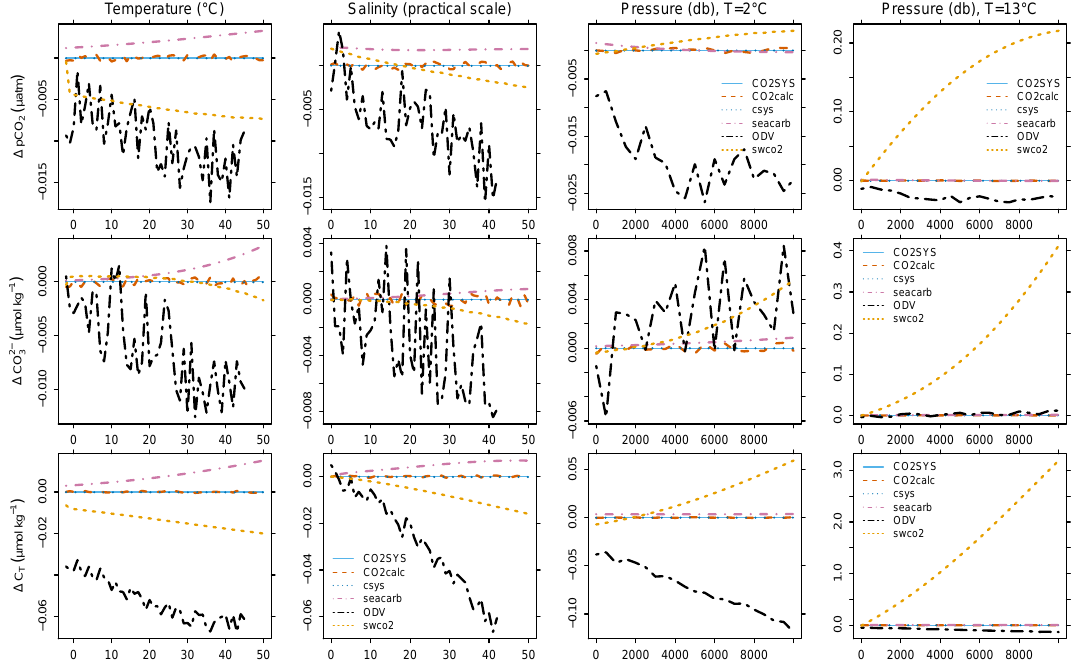
Figure 6. Variables computed from A T and pH with each package minus corresponding results from CO2SYS-MATLAB. Shown are com- puted p CO 2 (top), CO 2 − (middle), and C T (bottom) across ranges of T (column 1), S (column 2), and P when T = 2 ◦ C (column 3) and 3 when T = 13 ◦ C (column